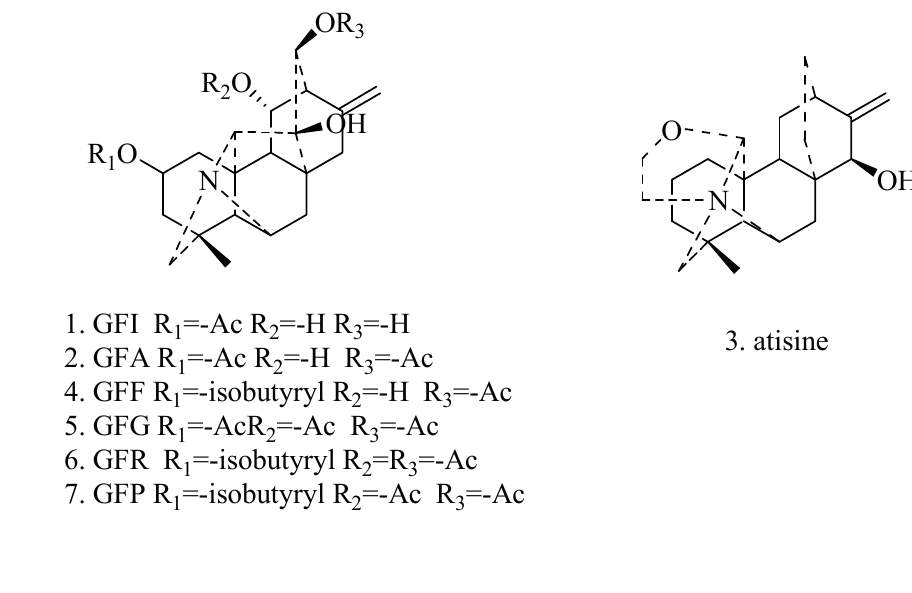
Figure 1. Chemical structures of compounds from Aconitum coreanum (Lèvl.)